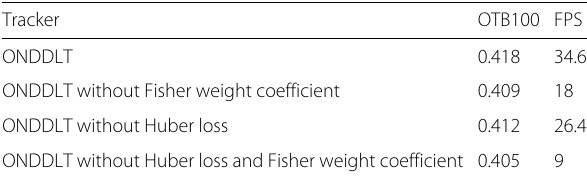
Table 1 Evaluation results of ONDDLT with/without Fisher weight coefficient and Huber loss on OTB100 dataset